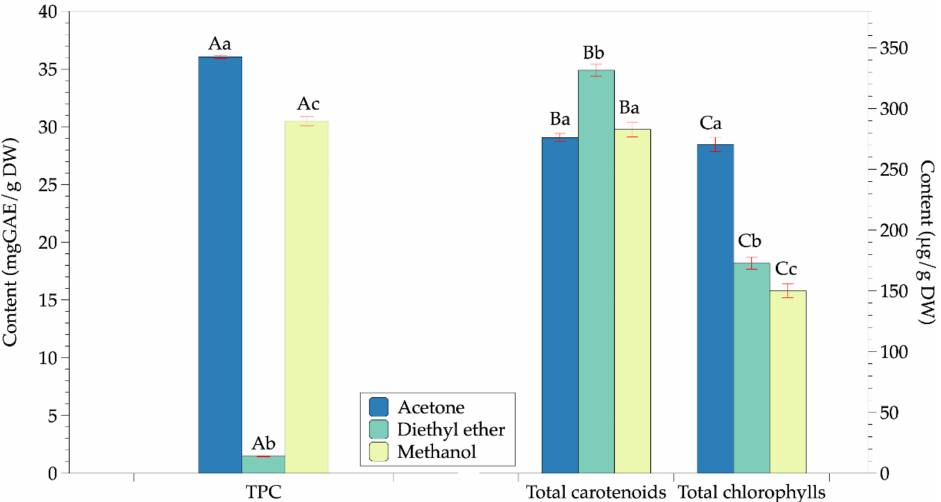
Figure 2. Effects of solvents on the total phenolics content (TPC) and the content of phytopigments of avocado extracts. Note: capital letters represent the same group of responding variables, and values within a group with the same lowercase letters are not significantly different ( p > 0.05).